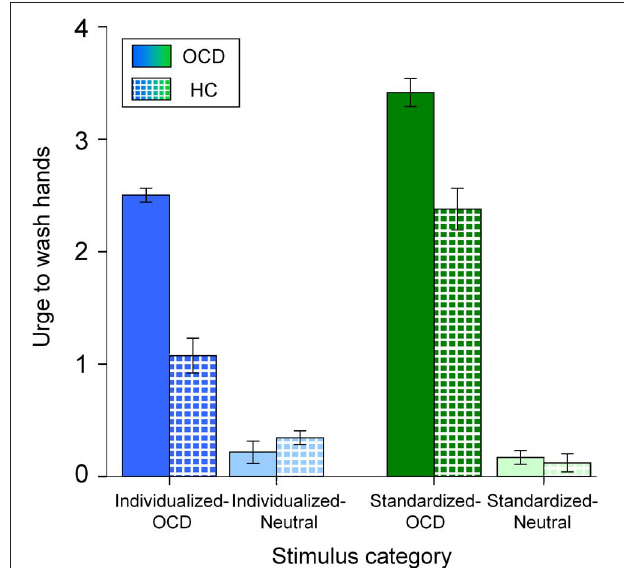
FIGURE 2 | Mean urge to wash hands (and standard errors of the mean) of patients (OCD; solid colors) and healthy controls (HC; patterned) for all stimulus categories. Note that the different colors depict the stimulus categories (dark blue: Individualized-OCD ; light blue: Individualized-Neutral ; dark green: Standardized-OCD ; light green: Standardized-Neutral; also cp. Figure 1